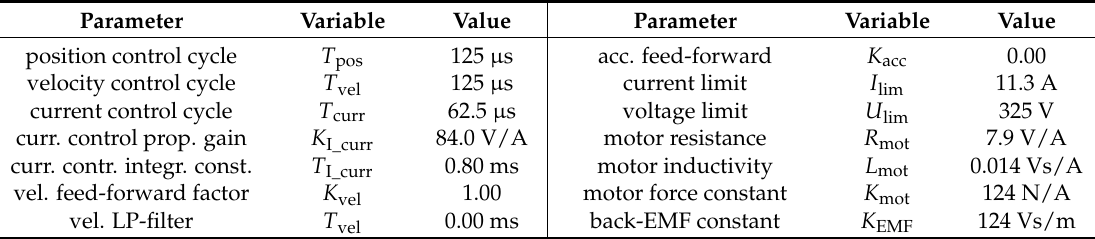
Table A1. Additional parameters of drives and control system of the test